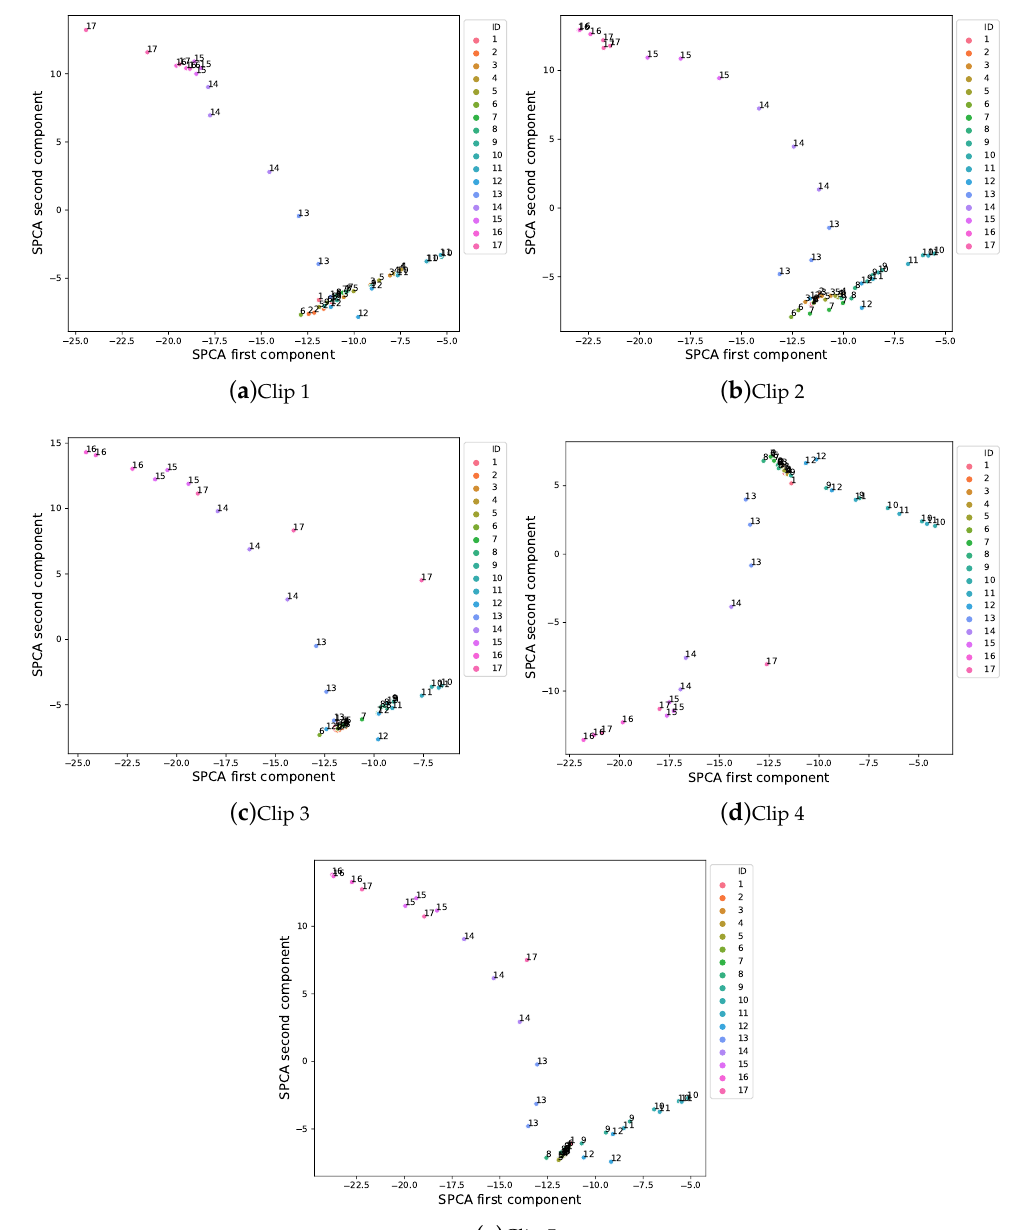
Figure 9. Plots representing for each of the five clips in the UserWGaze dataset the first two components of the SPCA projected data. Different labels and colors represent the ground truth information of the subject identity. Even considering only two components, a robust data aggregation for the same user is observable in the majority of the cases. It can be observed that this cluster is more or less compact depending on the different depicted situation of the